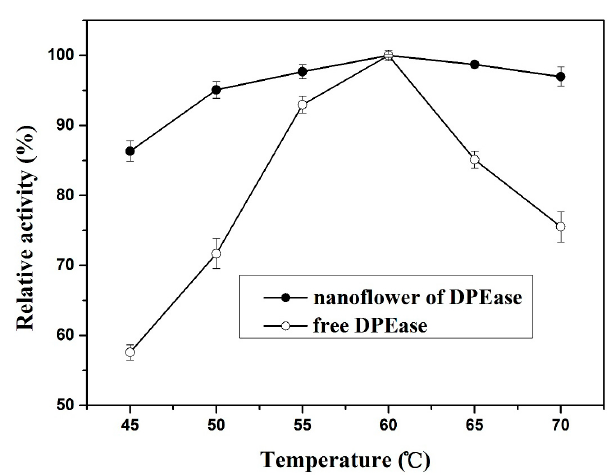
Figure 3. Effect of temperature on nanoflower and free DPEase. The enzyme activities of nanoflower (36.2 U/mg) and free DPEase (5.0 U/mg) at 60 °C were both 100%.